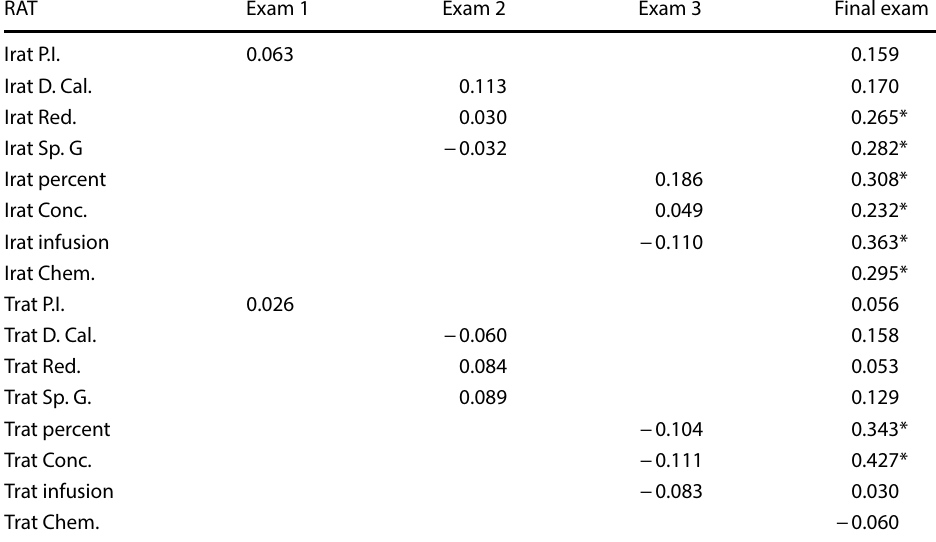
Table 2 Correlation of IRAT and TRAT scores with exam scores in Cohort